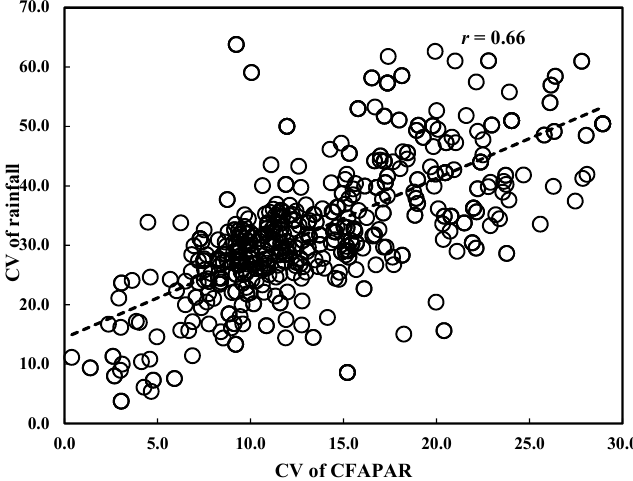
Figure 13. Linear relationship between the coefficient of variation (CV) of CFAPAR and that of rainfall. Samples located inside cropland mask were randomly selected using the Create Random Points tool of ArcGIS software.